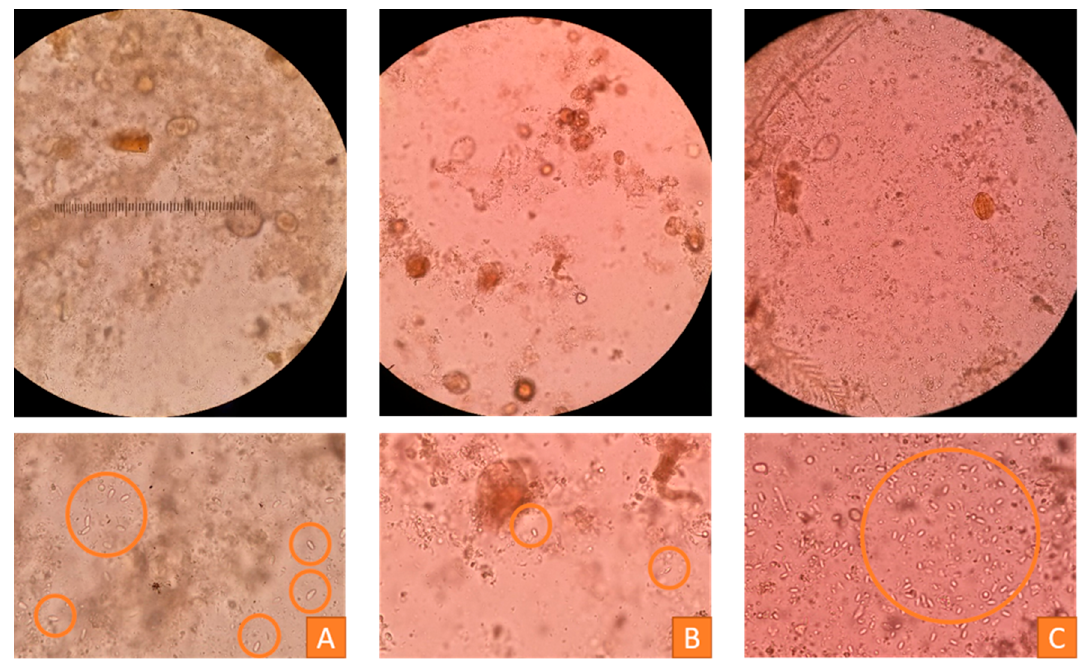
Figure 12. Microscopic investigation of bee samples of two honeybee colonies to estimate nosemosis infestation (400×), orange circles = Nosema spores (oval-shaped, 4–7 µm in length, 2–4 µm in width), upper row = visual fields, lower row = close-ups. ( A ) Sample of a colony with a moderate infestation (between 20 and 100 spores per visual field), ( B ) sample of a colony with a slight infestation (less than 20 spores per visual field), ( C ) sample of a colony with a severe infestation (more than 100 spores per visual field), © Julia Dittes.